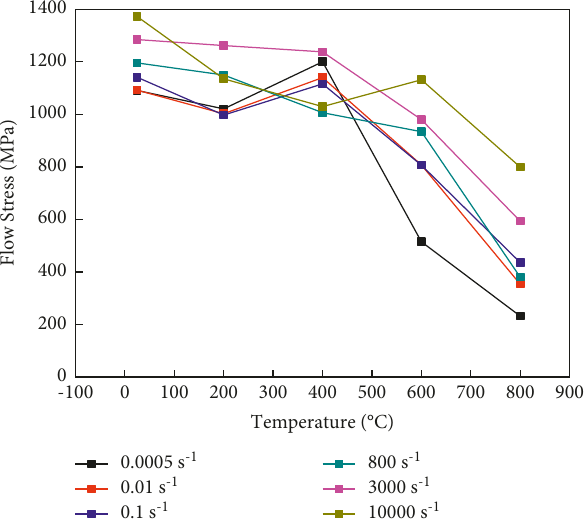
Figure 7: Effects of temperature on the flow stress of U71Mn rail steel at ε �